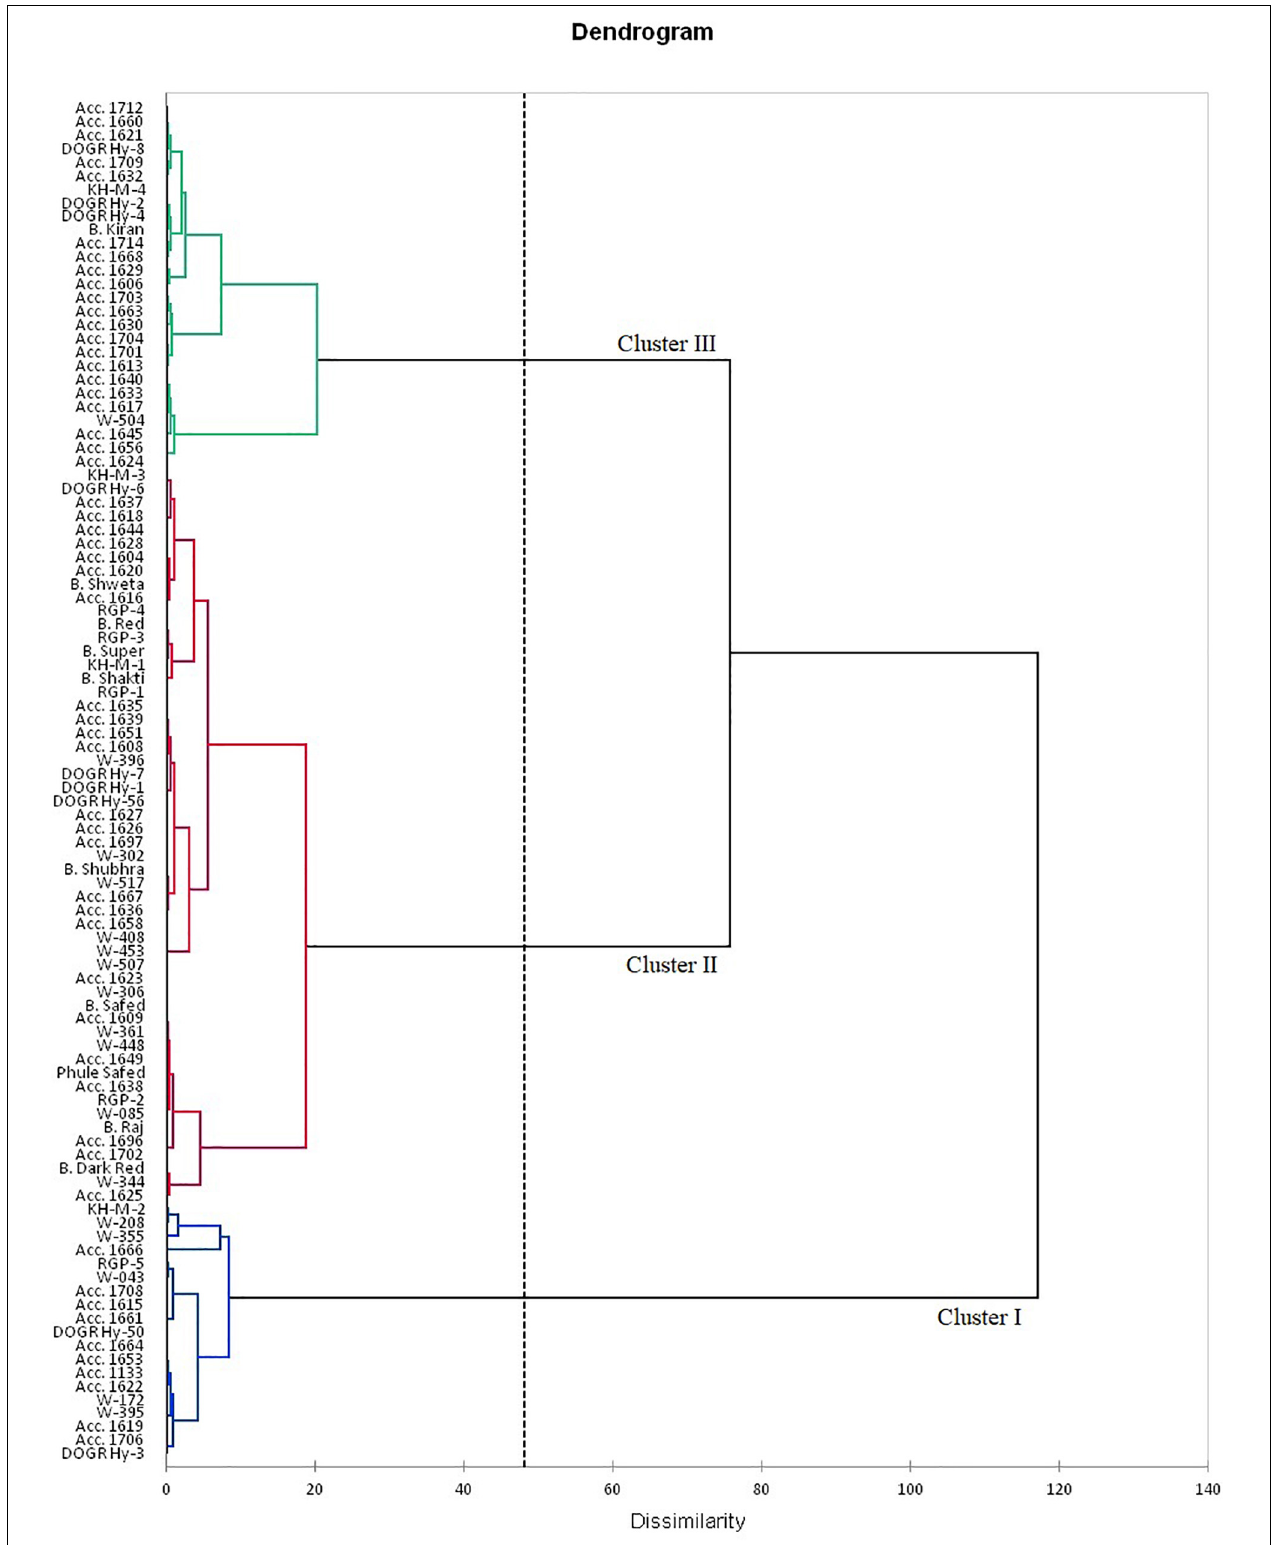
FIGURE 2 | Dendrogram using Ward’s method for distributing 100 onion